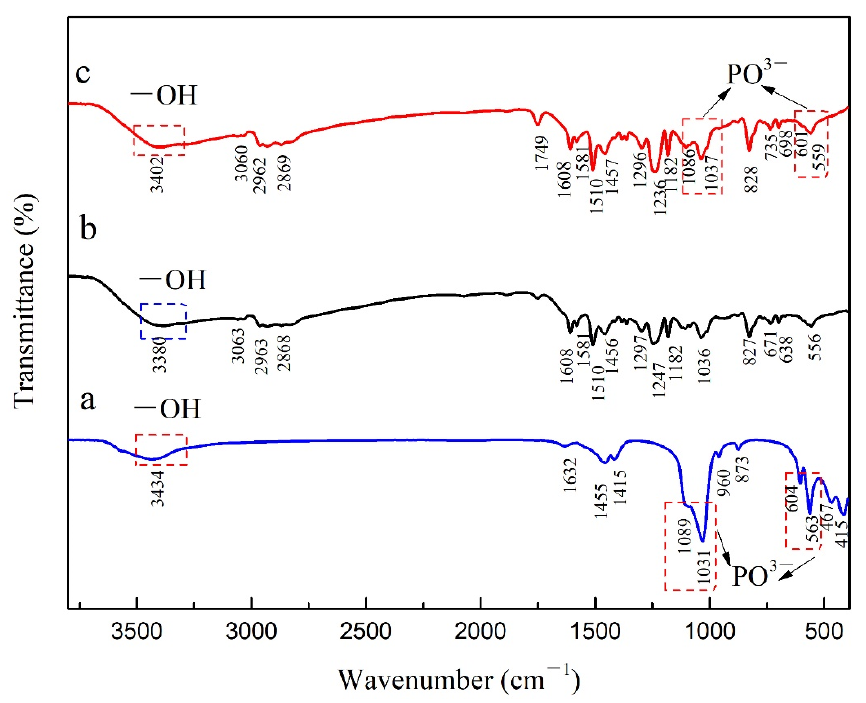
Figure 3. FT-IR spectra of samples ( a ) ZnO-HAP (65 wt.% ZnO + 35 wt.% HAP), ( b ) epoxy resin coating, and ( c ) ZnO-HAP (65 wt.% ZnO + 35 wt.% HAP)/epoxy resin coating.